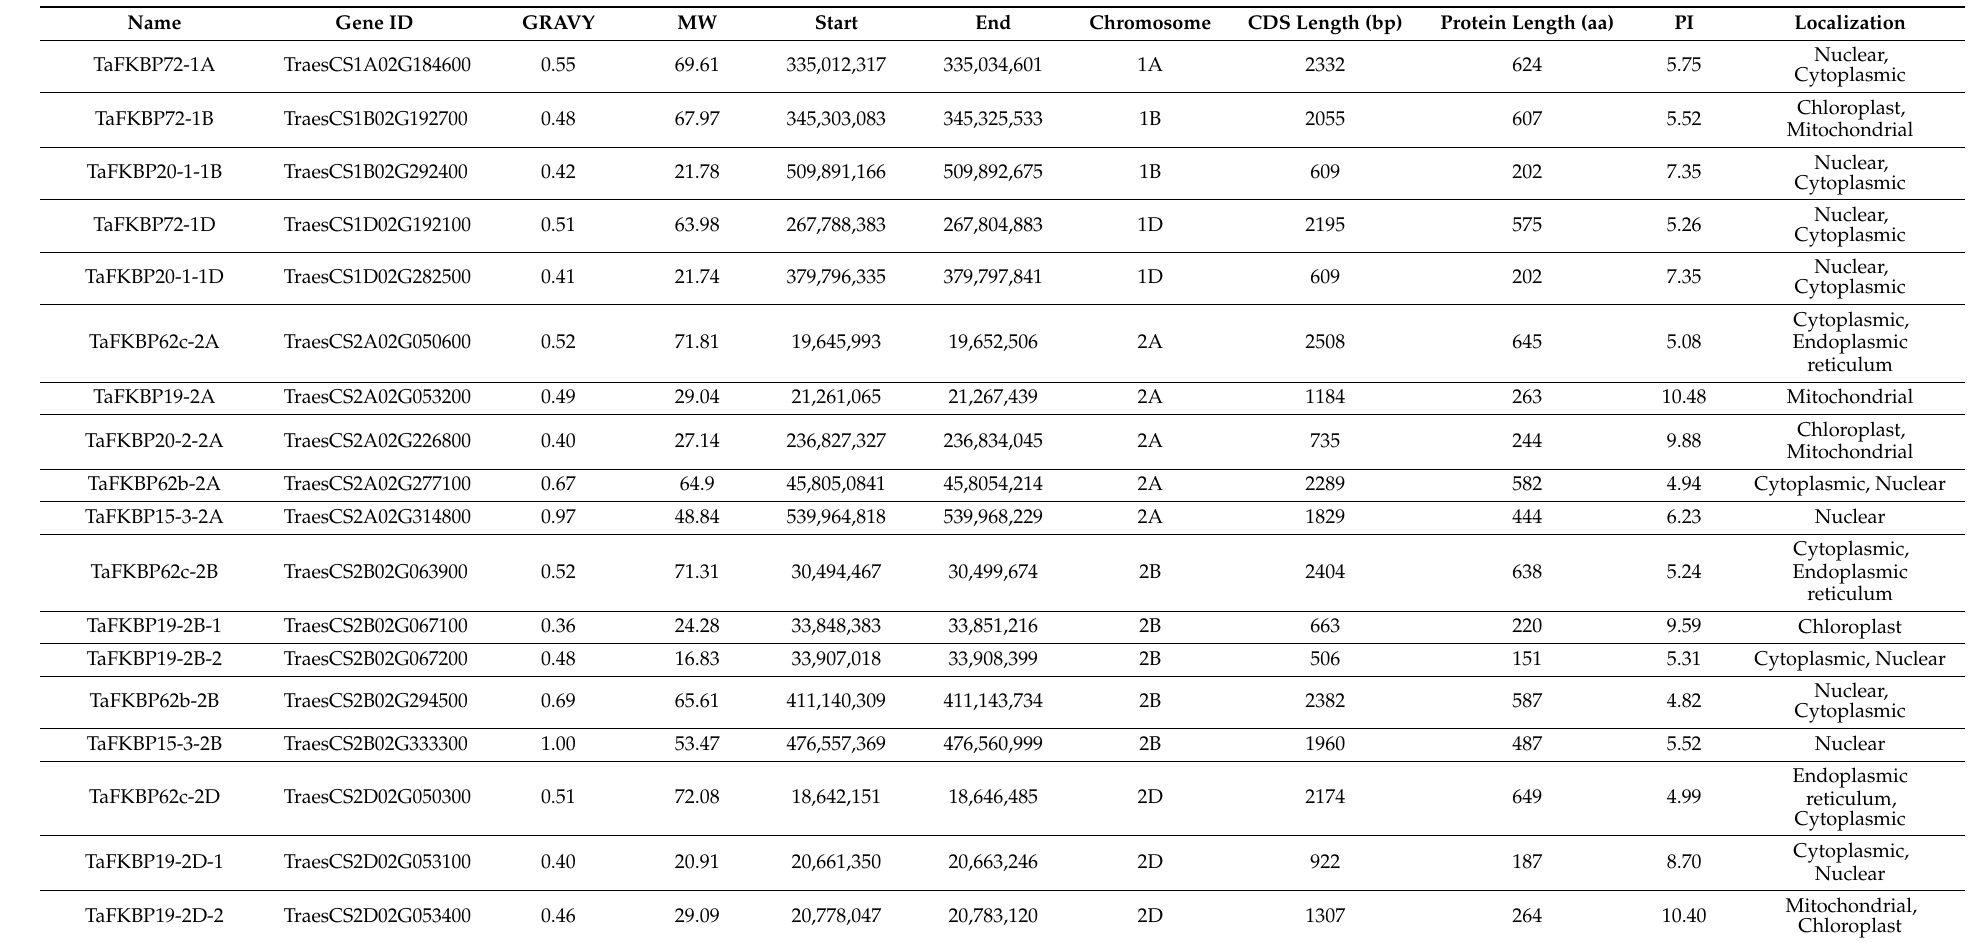
Table 1. Nomenclature and characteristics of the putative FKBP proteins in